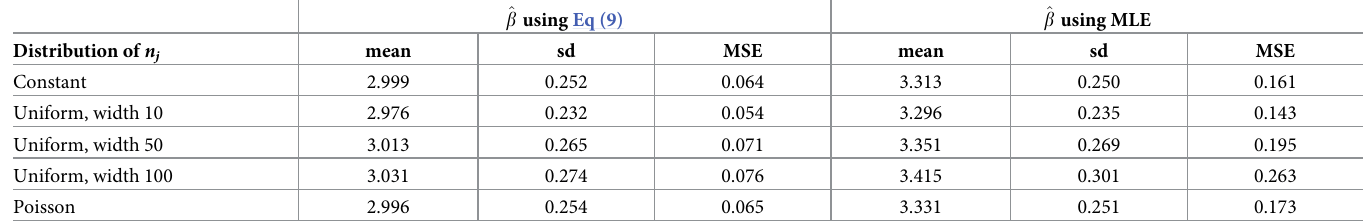
Table 1. Comparison of the estimates for the mean of the exponential distribution using Eq (9) versus maximum likelihood estimation, from 100 simulations with true value of β = 3. ^ b using Eq (9) ^ b using MLE Distribution of n j